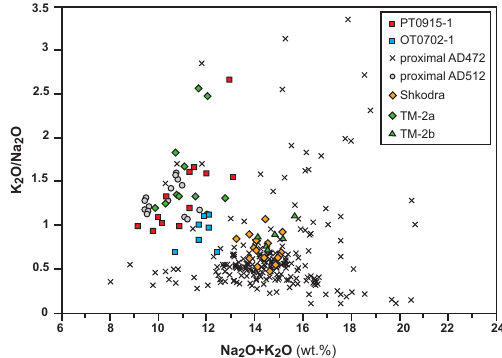
Fig. 7. Na 2 O+K 2 O vs. K 2 O/Na 2 O diagram showing the geochem- ical discrimination between the 472AD and 512AD eruption (prox- imal deposits; Santacroce et al., 2008; Table S2 in the Supplement). For comparison, data of distal deposits (Shkodra, Sulpizio et al., 2009; OT0702-1, Vogel et al., 2010; TM-2, Wulf et al., 2004; Ta- ble S2 in the Supplement) are also presented. Cryptotephra PT0915- 1 favours correlation with 512AD and